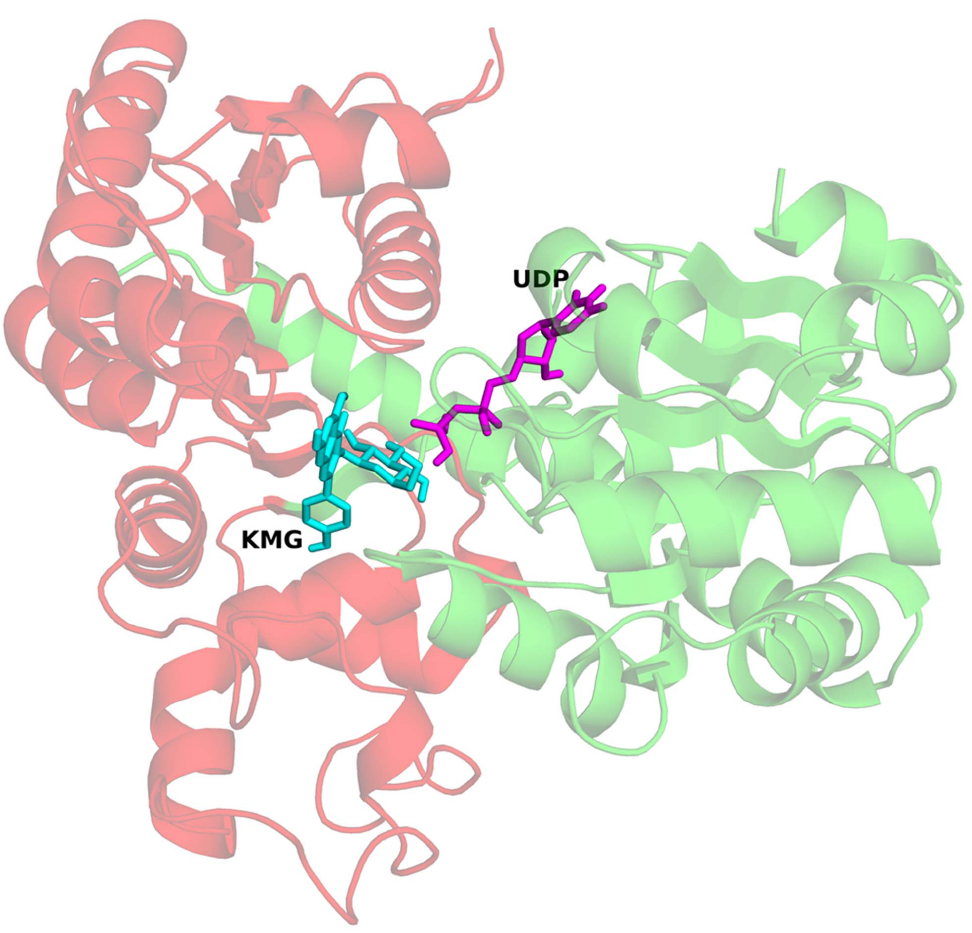
Figure 7. Docked complex of UGT with kaempferol-3-O-glucoside and UDP. Ribbon view of UGT from F. ananassa with docked Kaempferol- 3-O-glucoside and UDP shown in stick form.